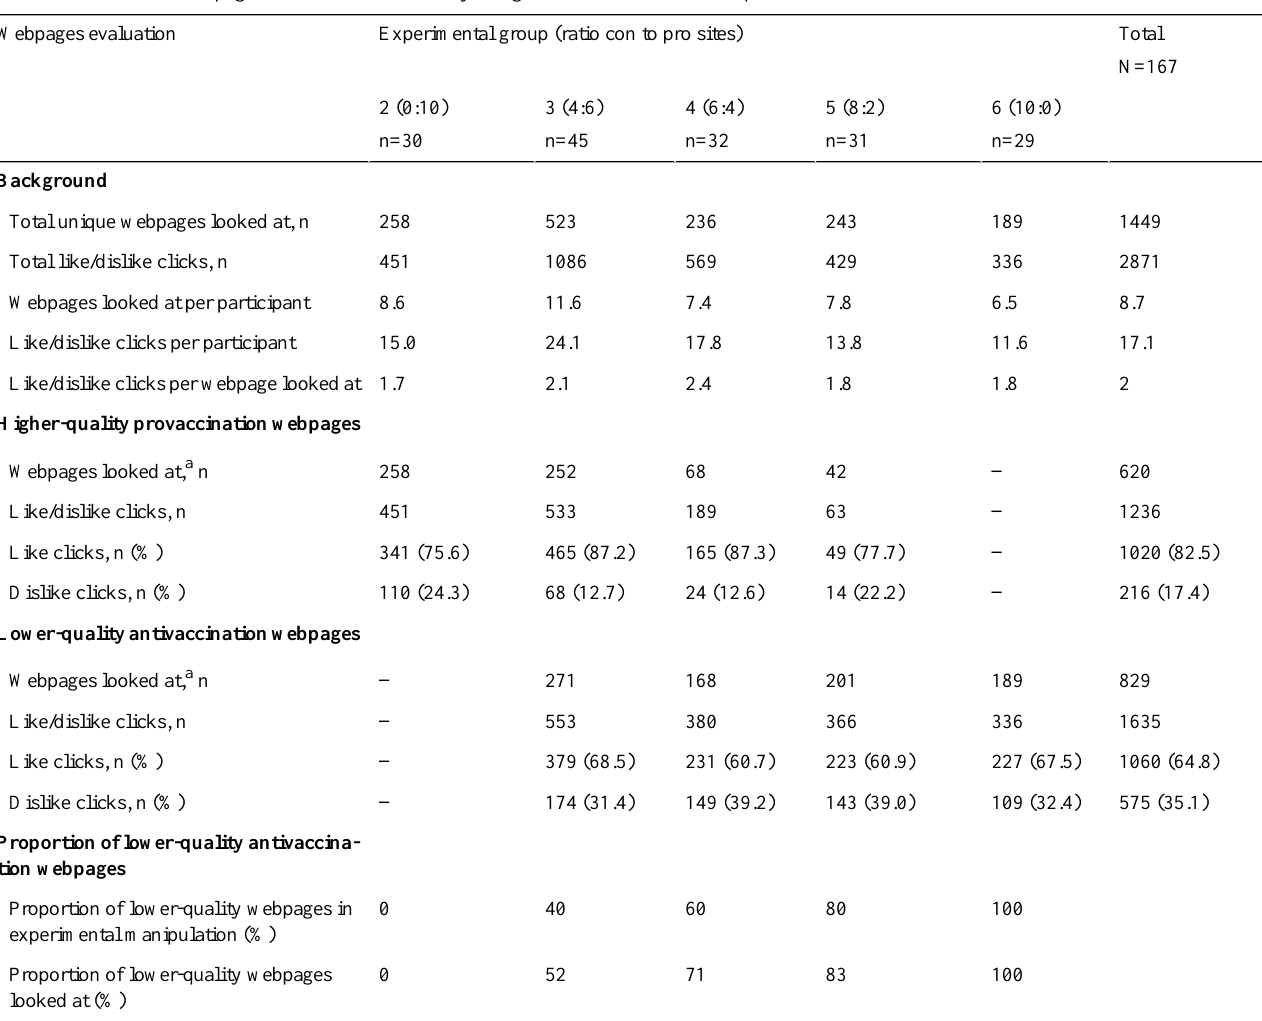
Table 5. Overview of webpage choice and evaluation by using the like/dislike button (experiment